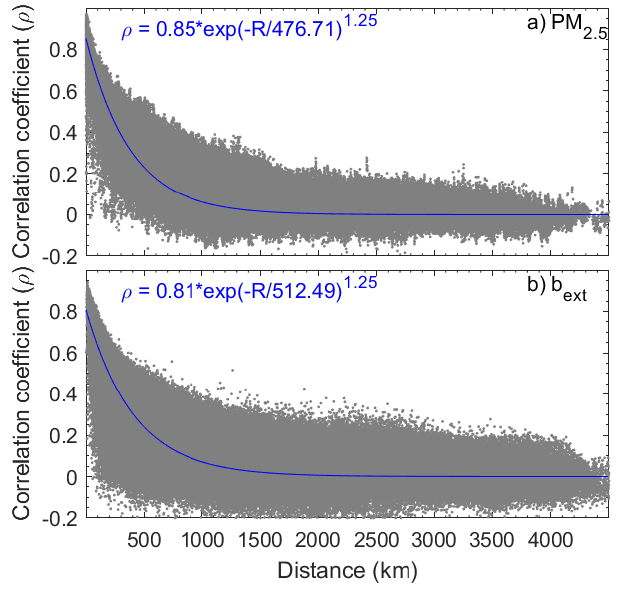
Figure 2. The scatterplot of correlation coefficient ( ρ ) versus station distance ( R ) for PM 2.5 ( a ) and b ext ( b ). An exponential equation is derived to describe the relationship between ρ and R , which is also shown.